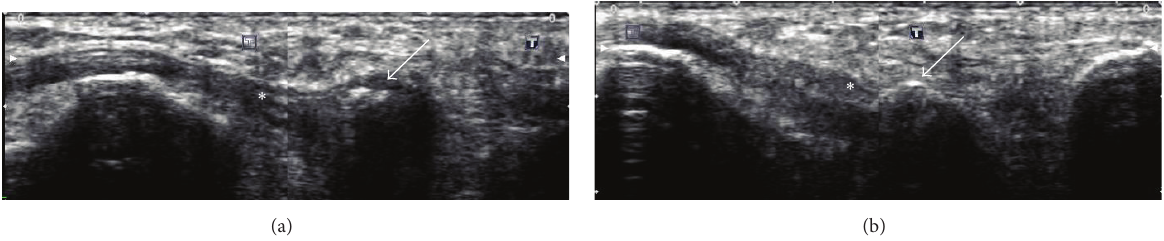
Figure 3: 60-year-old female ultrasonography of the long axis of the peroneus longus tendon. (a) Right foot: complaint side demonstrating a thickened and heterogeneous peroneus longus tendon (asterisk) and irregular and fragmented os peroneum, associated with swelling of the surrounding soft tissues. (b) Left foot: contralateral side for comparison, demonstrating a preserved echotexture of the peroneus longus tendon (asterisk) and regular contours of the os peroneum without changes in the surrounding soft